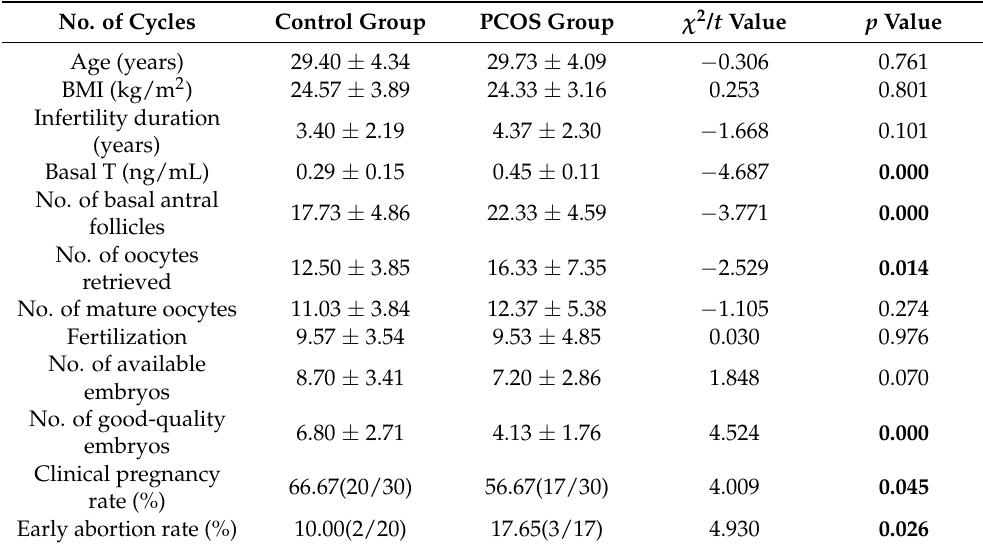
Table 1. Comparison of basic clinical information and pregnancy-assisted outcomes for the two